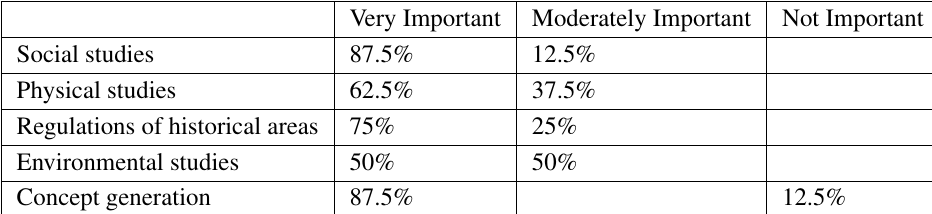
Table 2. From yourpoint of view, which of these dimensions were more important?